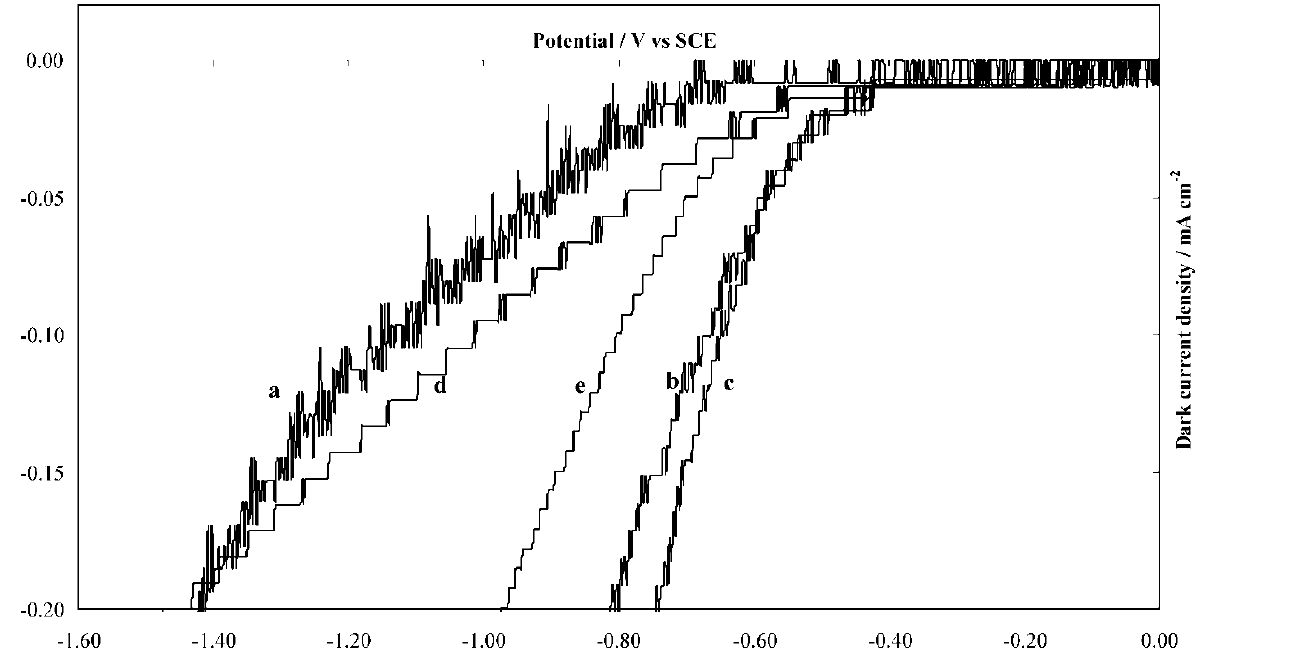
FIGURE 2 Dark J – V plots for (a) unheated n -Si. Slowly cooled n -Si samples from (b) 400 (cid:1) C, (c) 500 (cid:1) C, (d) 600 (cid:1) C, and (e) 700 (cid:1) C. All J – V measurements were conducted in water = LiClO 4 = K 4 [Fe(CN) 6 ] = K 3 [Fe(CN) 6 ] at 25 (cid:1)